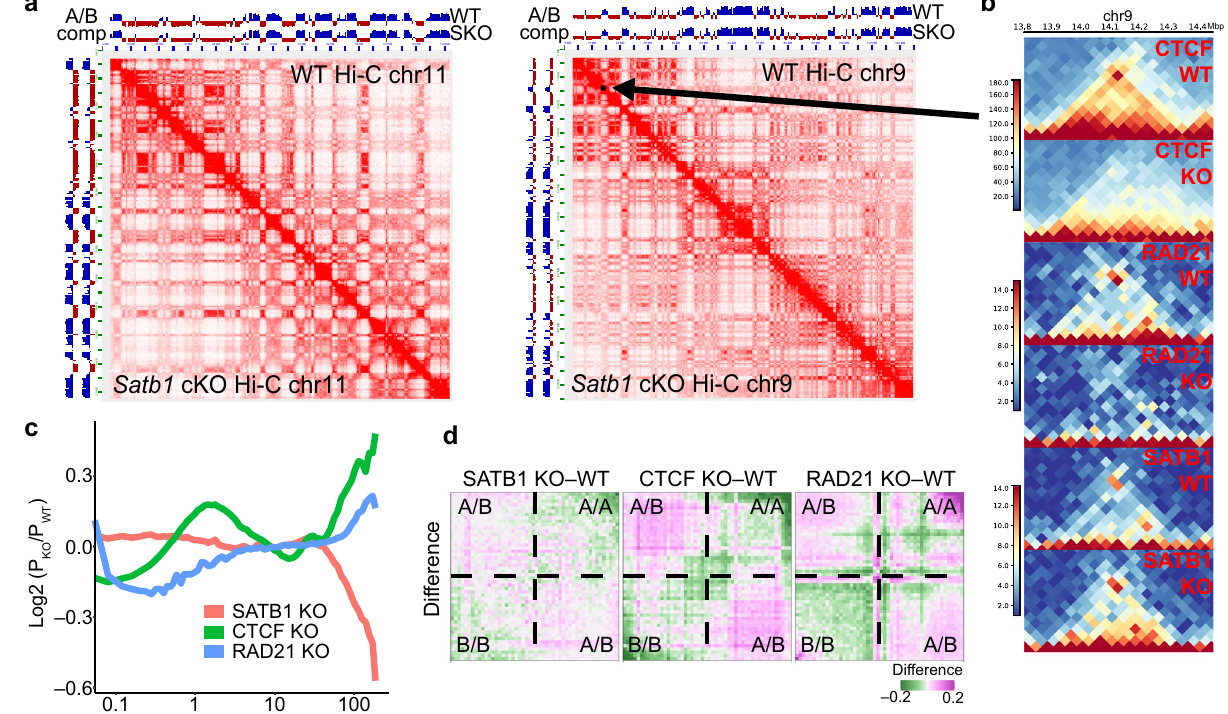
Fig. 2 | Roles of genome organizers in T cell chromatin organization. a ComparisonofWTand Satb1 cKOHi-Cheatmapsat500kbpresolution(balanced normalization) of chromosomes 9 and 11 indicates no major changes at the high order chromatin level of murine thymocytes. b Zoomed-in region of chromosome 9(indicatedbyablackarrowin a )depictsatopologicallyassociatingdomainandits disruption in CTCF-depleted mESCs 6 and RAD21-depleted DP T cells 56 but not in SATB1-depleted murine thymocytes (this study). c Genome-wide log2 fold change of relative contact probabilities between WT and SATB1-, CTCF- and RAD21-